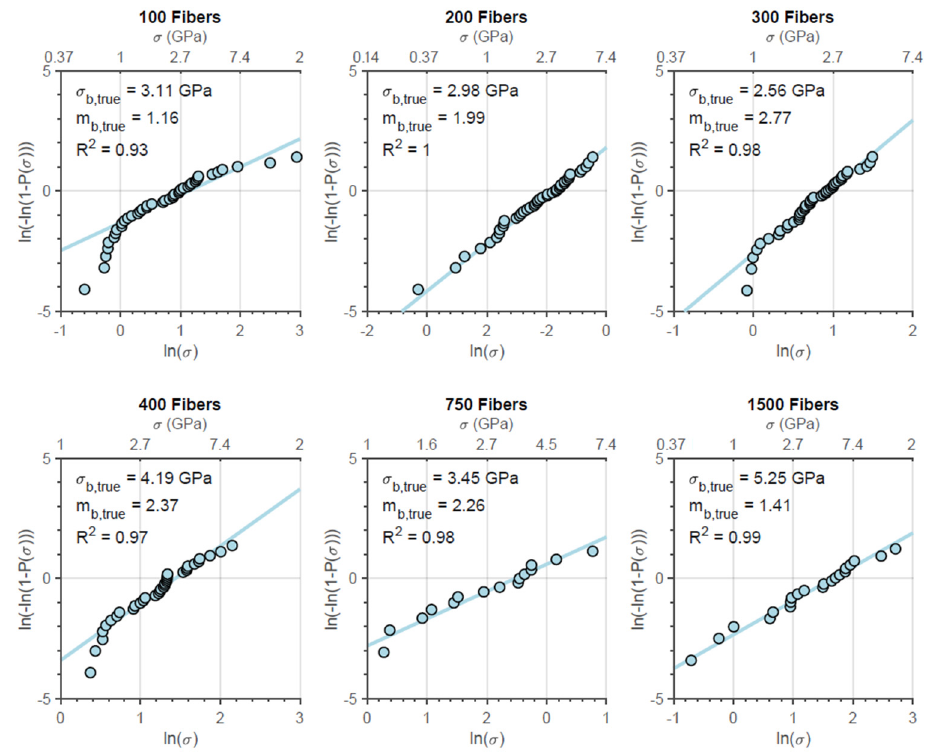
Figure 8. Weibull plots for N610 fiber bundles with different initial amounts of fibers.